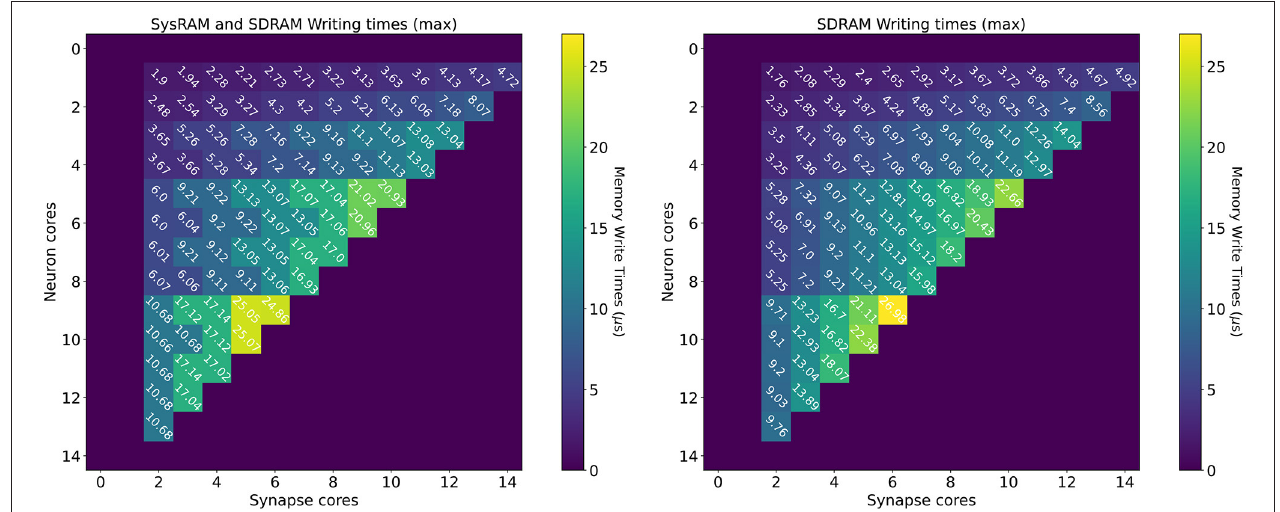
FIGURE 8 | Memory heatmaps showing worst case DMA writing Timings for increasing Synapse and Neuron cores. Synapse cores are represented on the horizontal axis, target Neuron cores on the vertical. All the measured times are in µ s. The two plots represent the dual memory (left) and the SDRAM only case (right) . Purple blocks represent configurations not allowed by the